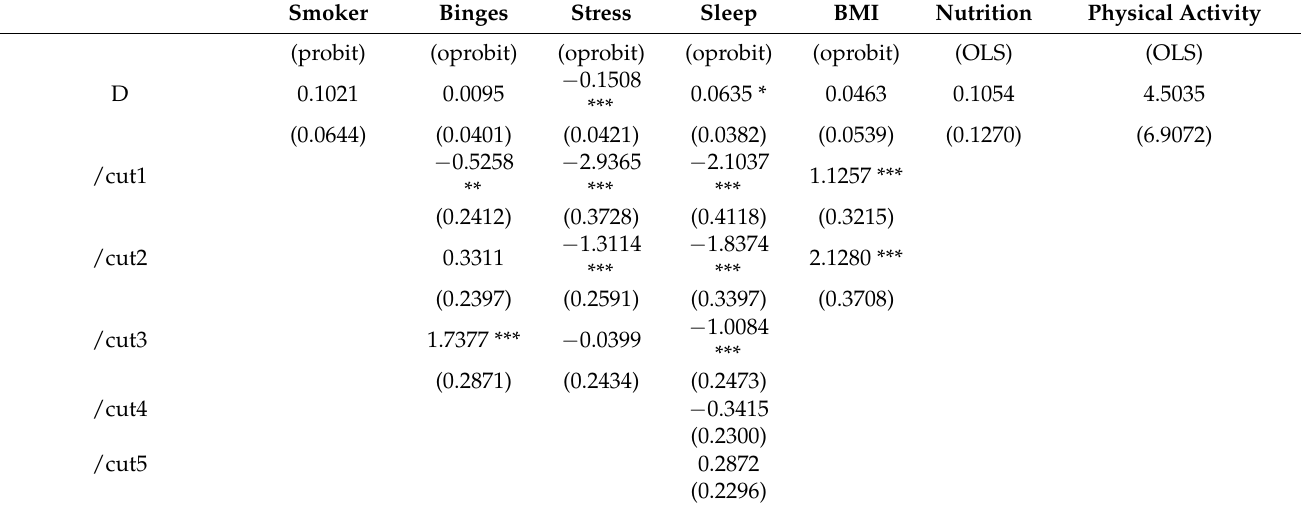
Table A4. Regressions with only